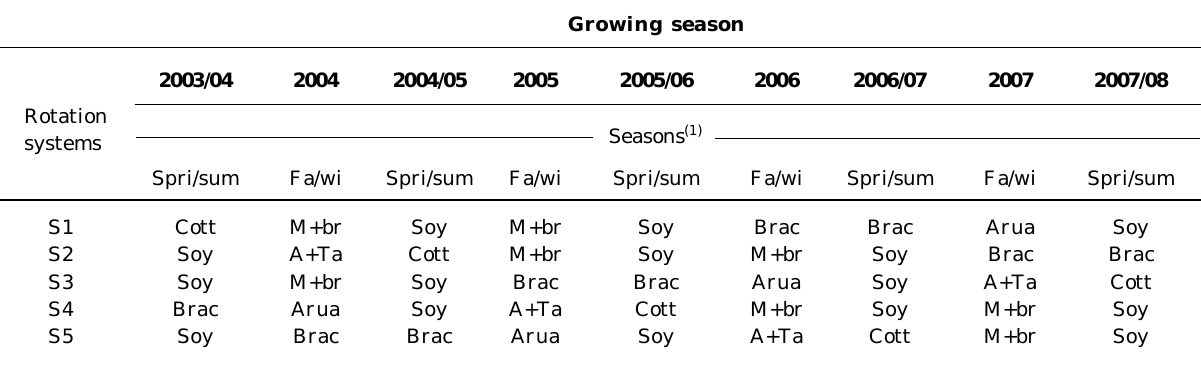
Cott = cotton; M+br = Maize + Brachiaria ruziziensis ; Brac = Brachiaria ruziziensis ; Arua = aruana grass; A+Ta = Oat + Tanzania grass. (1) Spri/sum = Spring/summer; Fa/wi =